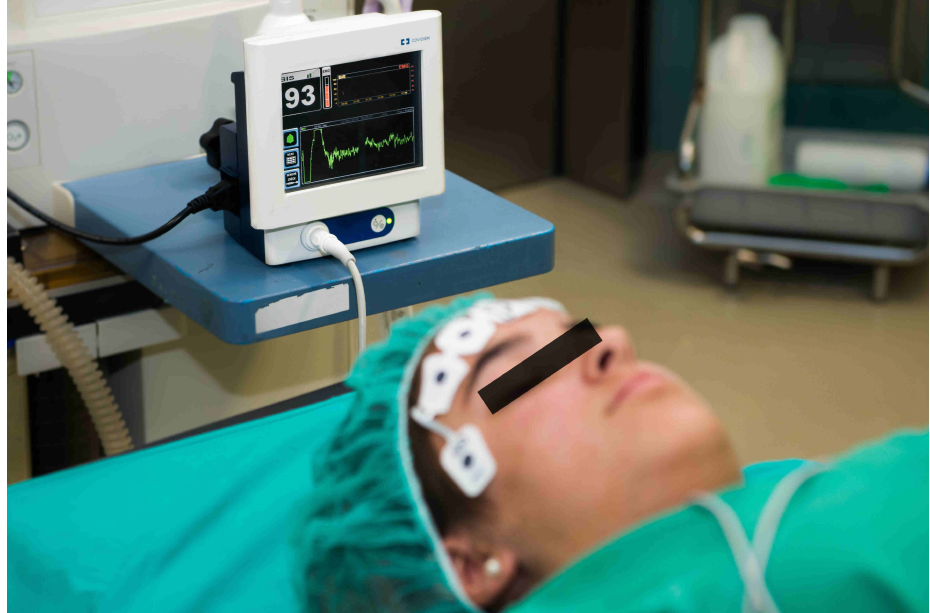
Figure 1. Bispectral Index (BIS) Vista monitor and a